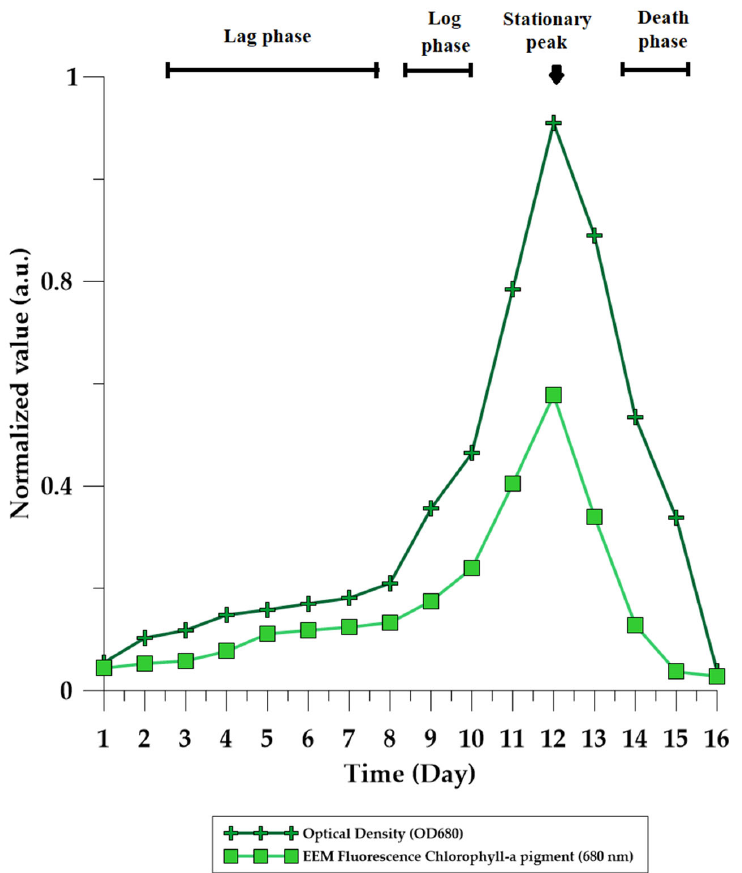
Figure 5. Optical density and EEM fluorescence measurements of C. reinhardtii at 680 nm. The growth phase of the algae is observable at specific cultivation parameters.